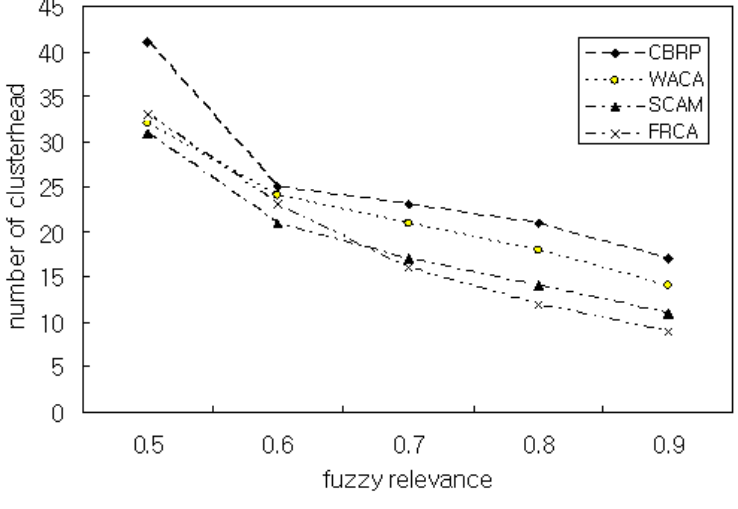
Figure 8. Number of Clusterheads with 0.5   